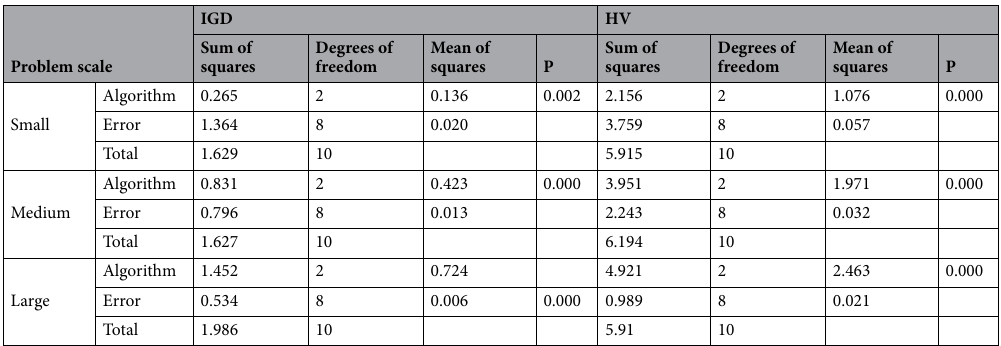
Mean of squares